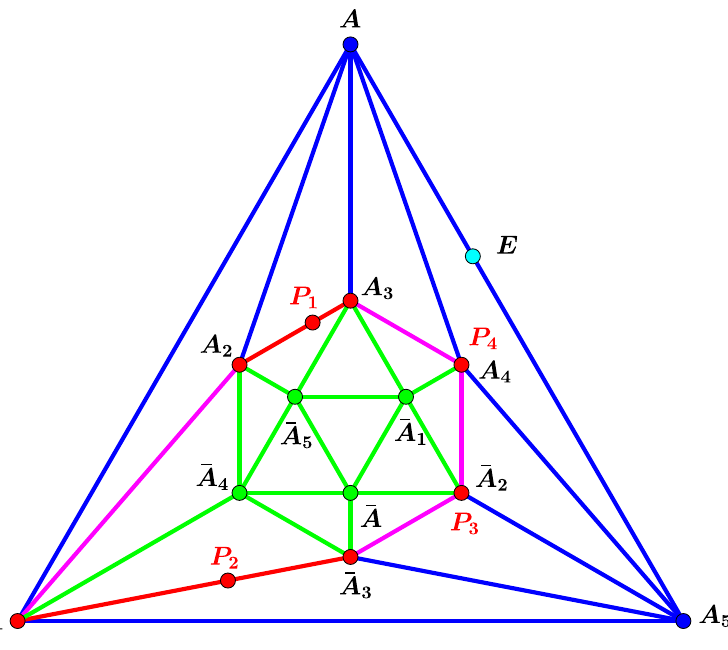
Figure 8. Location of the